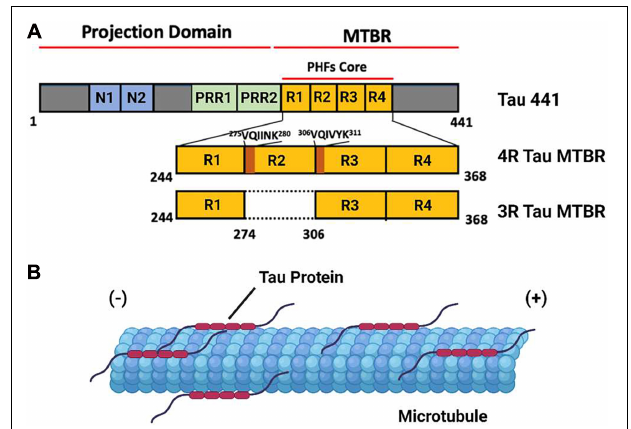
FIGURE 1 | The domain Structure and Function of Tau Protein. (A) A domain map of the tau 441 isoform and a comparison of the microtubule binding domain (MTBR) of 4R and 3R tau isoforms. The VQIINK and VQIVYK sites implicated in tau aggregation are highlighted in dark orange. (B) Under non-pathological conditions, tau protein associates with axonal microtubules and stabilizes the microtubule against